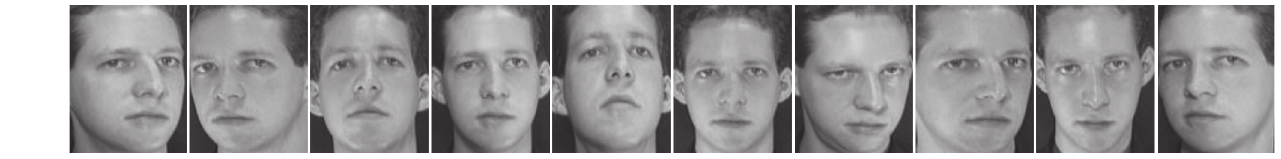
Figure 6: Ten views of a person from the ORL database. Table 1: Impact of the divisions on recognition rates